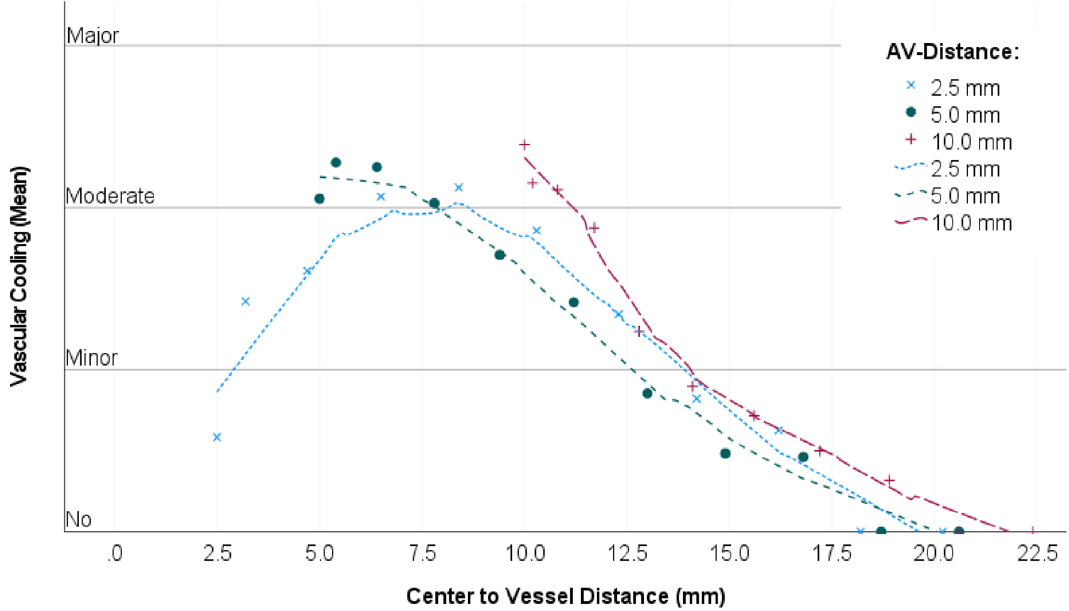
Figure 2. Semiquantitative analysis of vascular cooling effects dependent on the distance between the vessel to the ablation centre (all flow rates combined). The mean values for the cooling effects of all 1498 ablation slices were assessed. A local regression (LOESS) was used to plot the regression curves (dotted lines). A dependency between the distance of the vessel to the ablation centre was identified. Moderate cooling effects were seen when the vessel was located close to the ablation border (≈ 7.5 mm from the ablation centre). Minor cooling effects were seen in the ablation